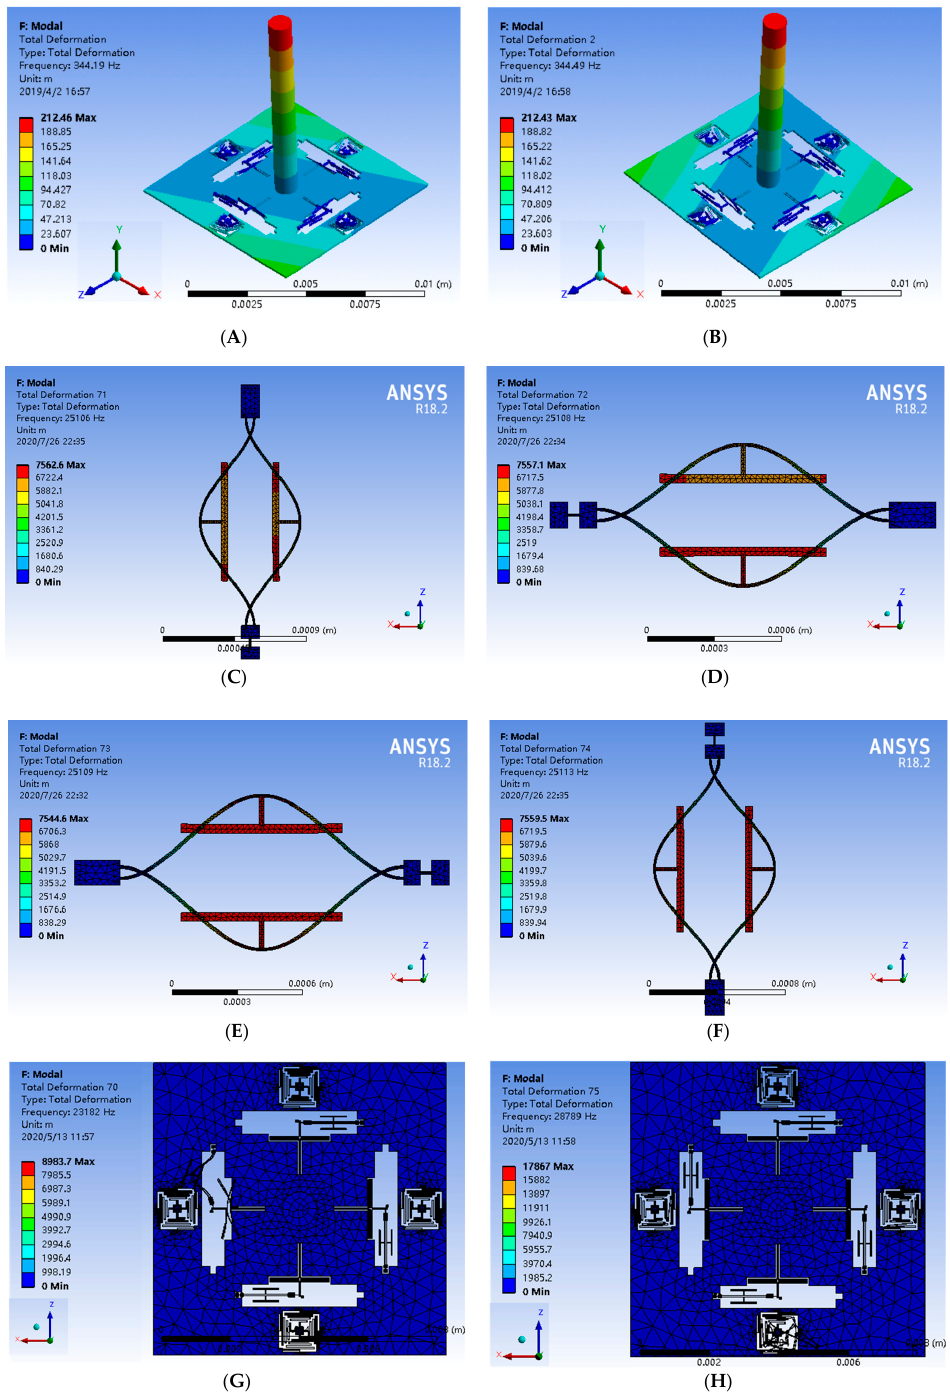
Figure 2. The mode simulation of the novel biaxial bionic hair flow sensor. ( A ) Sense mode 1. ( B ) Sense mode 2. ( C ) Working mode of left resonator. ( D ) Working mode of upper resonator. ( E ) Working mode of right resonator. ( F ) Working mode of lower resonator. ( G ) Interference mode 1. ( H ) Interference mode 2. Table 2. Effective modes of the novel biaxial bionic hair flow sensor.